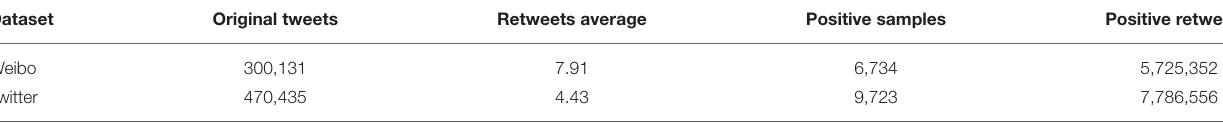
TABLE 1 | Summary of dataset statistics. Dataset